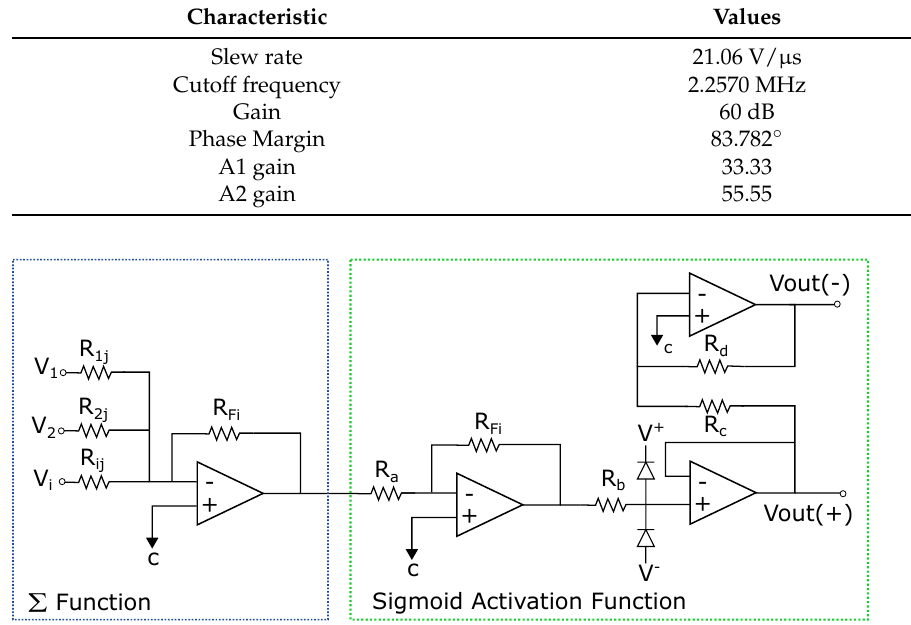
Figure 7. Circuit for one neuron. As shown in Figure 3, the architecture has 9 neurons (configuration 5-3-1), and each neuron has 4 op-amps due to the adder and the sigmoid activation function (see Table 6). The total power consumption is 46.08 mW, because there are 36 op-amps for the entire circuit, and each of them consumes 1.28 mW